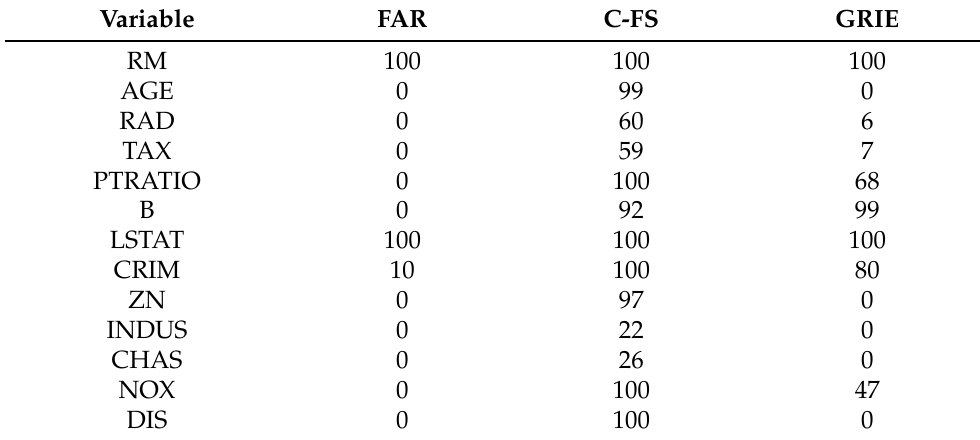
Table 8. The frequency for 13 real covariates being selected over 100 replications for Boston Hous- ing